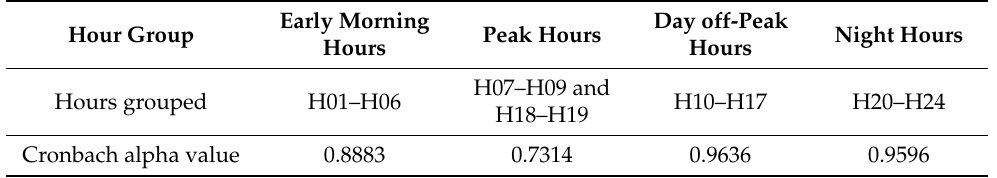
Table 3. Results of the reliability analysis of the annual average hourly traffic volume ratios to AADT